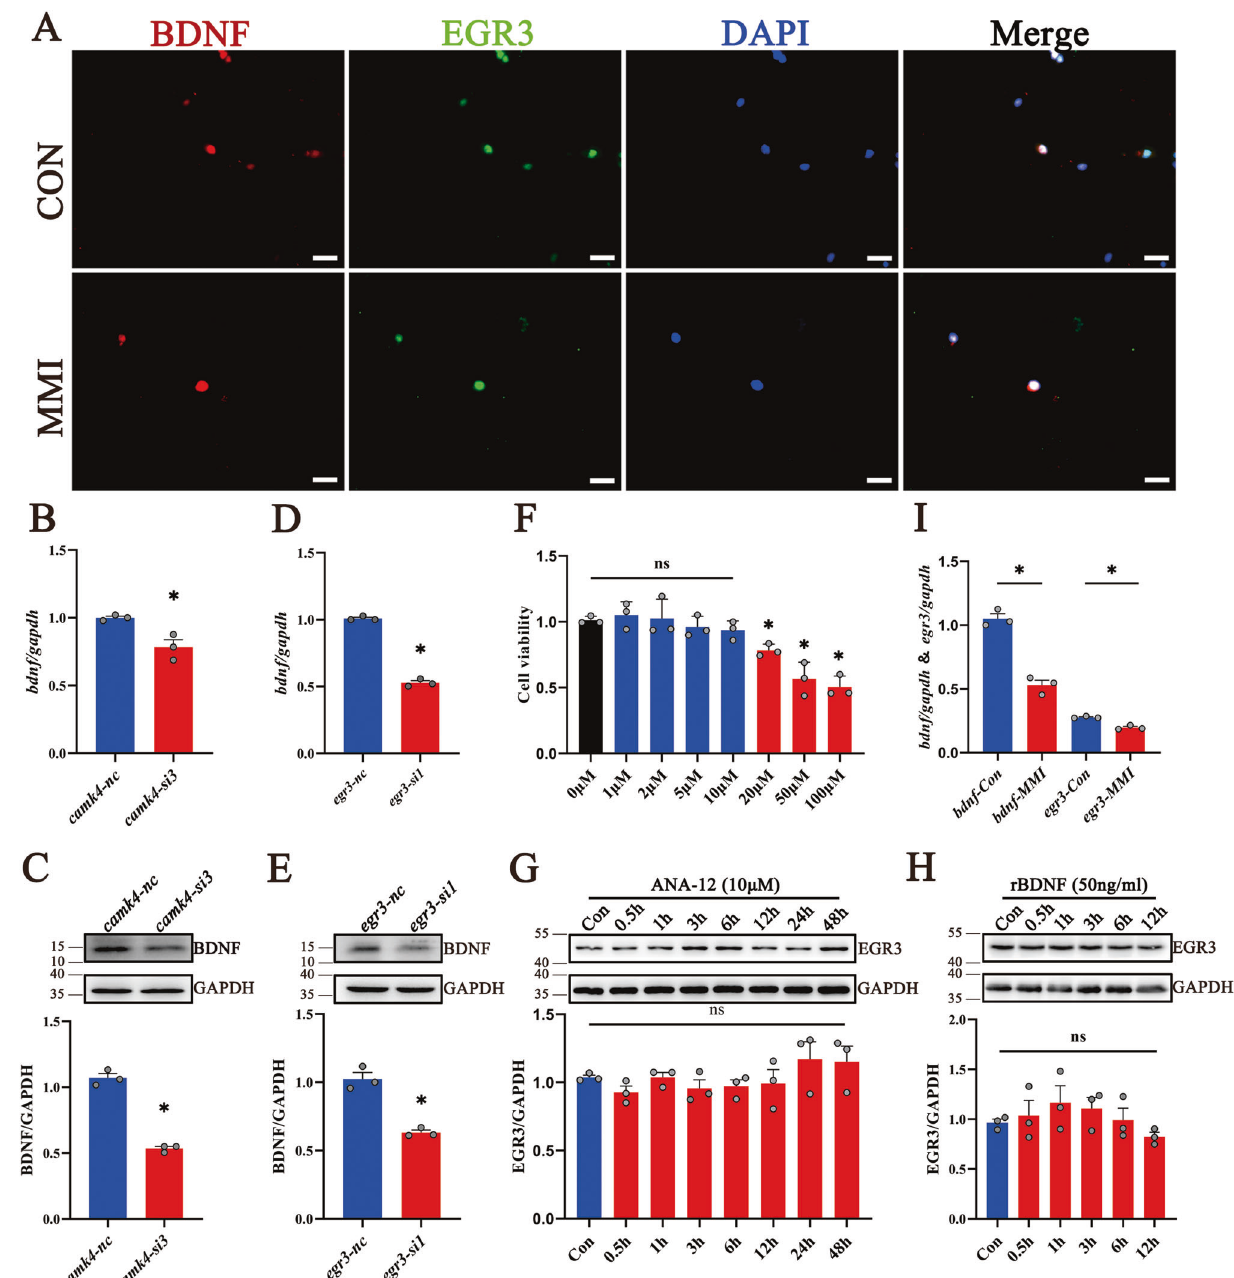
Fig. 7 Knockdown of CaMKIV/EGR3 downregulated BDNF expression in primary hippocampal neurons. A Primary hippocampal neurons were cultured from E18 fetal rats with or without CH. The co-localization of BDNF and EGR3 was observed by immuno fl uorescence staining. Scale bar: 20 μ m. B – E Analysis of BDNF levels following CaMKIV and EGR3 knockdown of primary hippocampal neurons for 24 h by RT-PCR ( B , D ) and western blot ( C , E ). F The cell viability of primary hippocampal neurons treated with different concentrations of ANA-12 for 24 h was detected by CCK8 kit. The cell viability decreased signi fi cantly when ANA-12 concentration was higher than 10 μ M. G Expression of EGR3 in primary neurons treated with ANA-12 10 μ M for the different times by western blot. H Expression of EGR3 in primary neurons treated with recombinant protein BDNF 50 ng/ml for the different times by western blot. I Transcriptional levels of EGR3 and BDNF in primary neurons cultured from hippocampus with or without CH by RT-PCR. Experiments were performed in triplicates. Error bars represent the standard error (* P < 0.05). 48 h. The hippocampus was sectioned into 100- μ m and pasted on 2% gelatin slide. The slices were dried at room temperature for 2 days, dyed with a mixture of solution D, solution E, and distilled water (1:1:3) for 10 min, and then dehydrated with gradient ethanol. Finally, neutral gum was used to seal the sections after treatment with xylene, and the density of hippocampal dendritic spines was observed under a microscope.